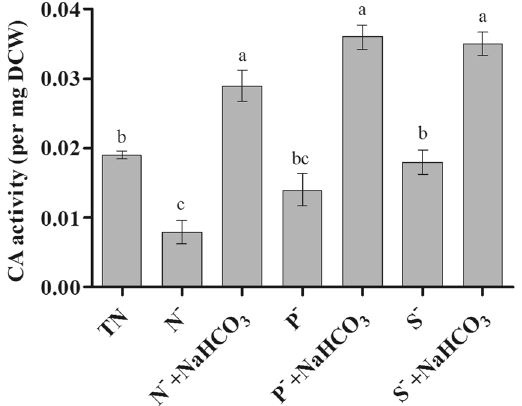
Figure 6. Changes in carbonic anhydrase activity of D. salina with bicarbonate under nutrient deficit conditions. All values are expressed as Mean ± SD (n = 3). Values with different letters represent significantly differ at p < 0.05 between the groups. Total Nutrient (TN); Nitrate deficit (N − ); Nitrate deficit with bicarbonate (N − + NaHCO 3 ); Phosphate deficit (P − ); Phosphate deficit with bicarbonate (P − + NaHCO 3 ); Sulphate deficit (S − ); Sulphate deficit with bicarbonate (S − + NaHCO 3